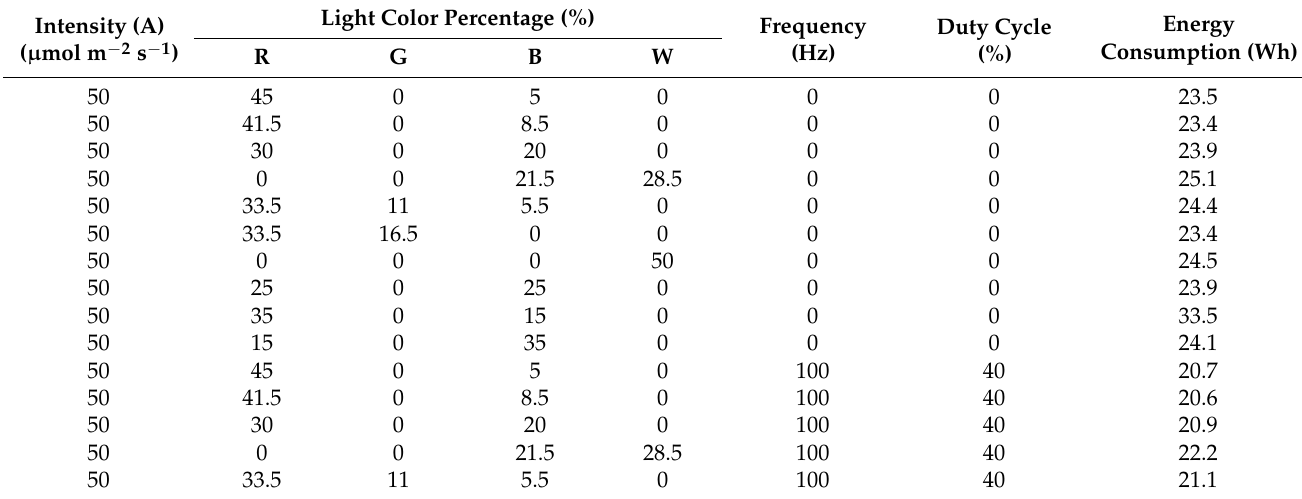
Table 1. First 15 measurements of the dataset generated.